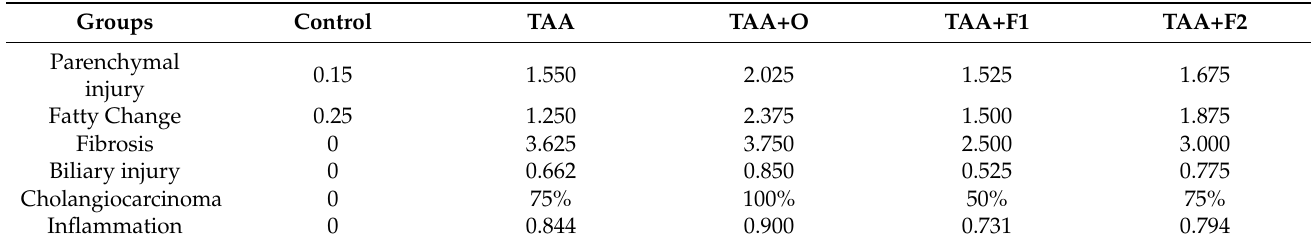
Figure 3. Representative micrographs of liver histology in control, and rats treated with thioacetamide (TAA), thioacetamide + virgin olive oil (TAA+O), thioacetamide + C60 fullerene lower dose (TAA+F1), and thioacetamide + C60 fullerene higher dose (TAA+F2). Fibrosis (Masson-trichrome staining): ( A ) liver without fibrosis in the control group, ( B ) mild periportal fibrotic expansion in TAA+F1 group, ( C ) bridging fibrosis in TAA group, and ( D ) cirrhosis in TAA+O group; Parenchymal injury (PAS staining): ( E ) small focus of fatty change in group TAA+F1, ( F ) more severe fatty change in TAA group, ( G ) ballooning degeneration in group TAA+F2, and ( H ) focal necrosis and fatty change in TAA+O group; Biliary injury (H&E staining): ( I ) normal morphology in the control group; ( J ) biliary pigment in TAA group; ( K ) biliary hyperplasia in TAA+O group; ( L ) cholangiocellular carcinoma in TAA+F1 group. Table 3. Liver histology score system. Average values in control, and rats treated with thioacetamide (TAA), thioacetamide + virgin olive oil (TAA+O), thioacetamide + C60 fullerene lower dose (TAA+F1), and thioacetamide + C60 fullerene higher dose